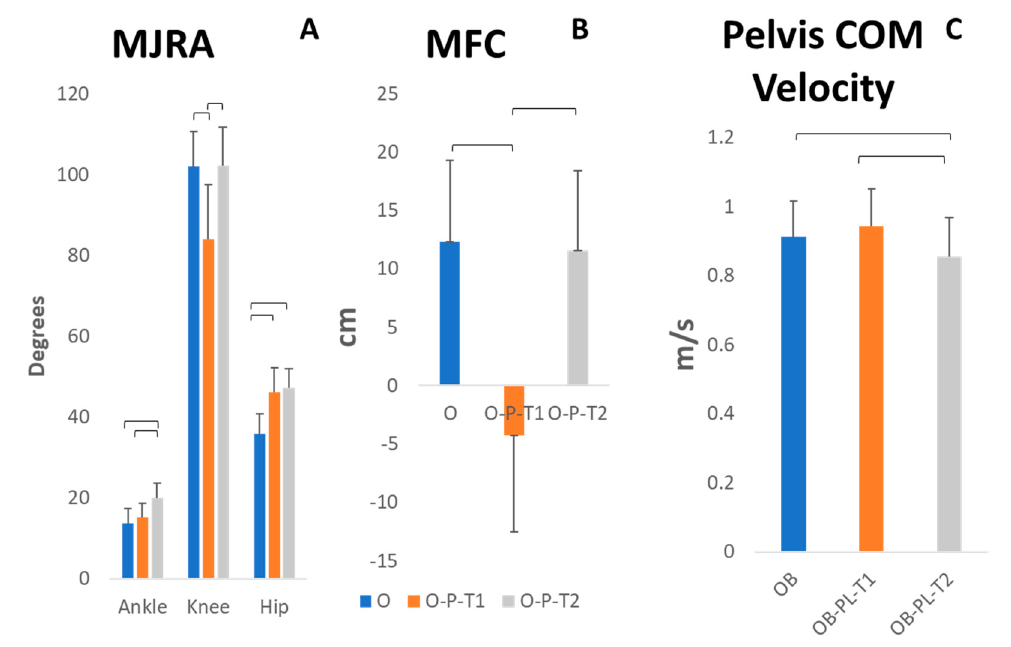
Figure 3. Average (standard deviation) of maximum joint relative angles (MJRA) during trailing limb swing phase ( A ). Minimal trailing limb foot clearance (MFC) of the obstacle—negative values correspond to the foot passing below obstacle level ( B ). Average pelvis center of mass (COM) velocity during trailing limb swing phase ( C ) across unperturbed (blue), early perturbation of obstacle to platform (O-P-T1, orange) and late perturbation (O-P-T2, gray) conditions.